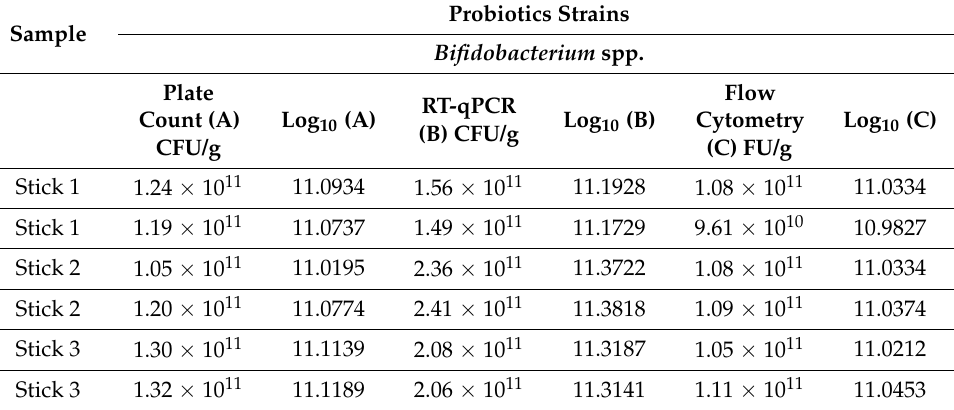
bacillus spp. vs. Bifidobacterium spp. is reported in Tables 9 and 10. Table 9. Measurements expressed as Log10 for Bifidobacterium spp. in food supplement 2, obtained by the three methods